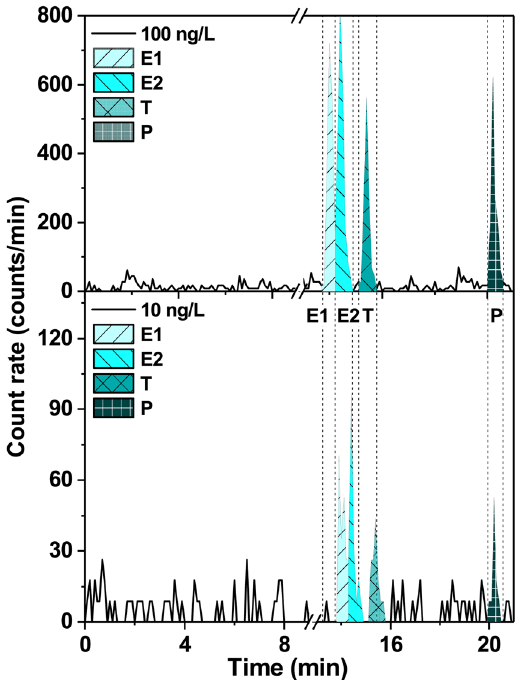
Figure 2. UHPLC-FSA radiochromatograms of a mixture of 3 H-labelled E1, E2, T and P hormones at two different concentrations (10 and 100 ng/L of each hormone). The elution conditions are presented in Supplementary Table S3 as “standard